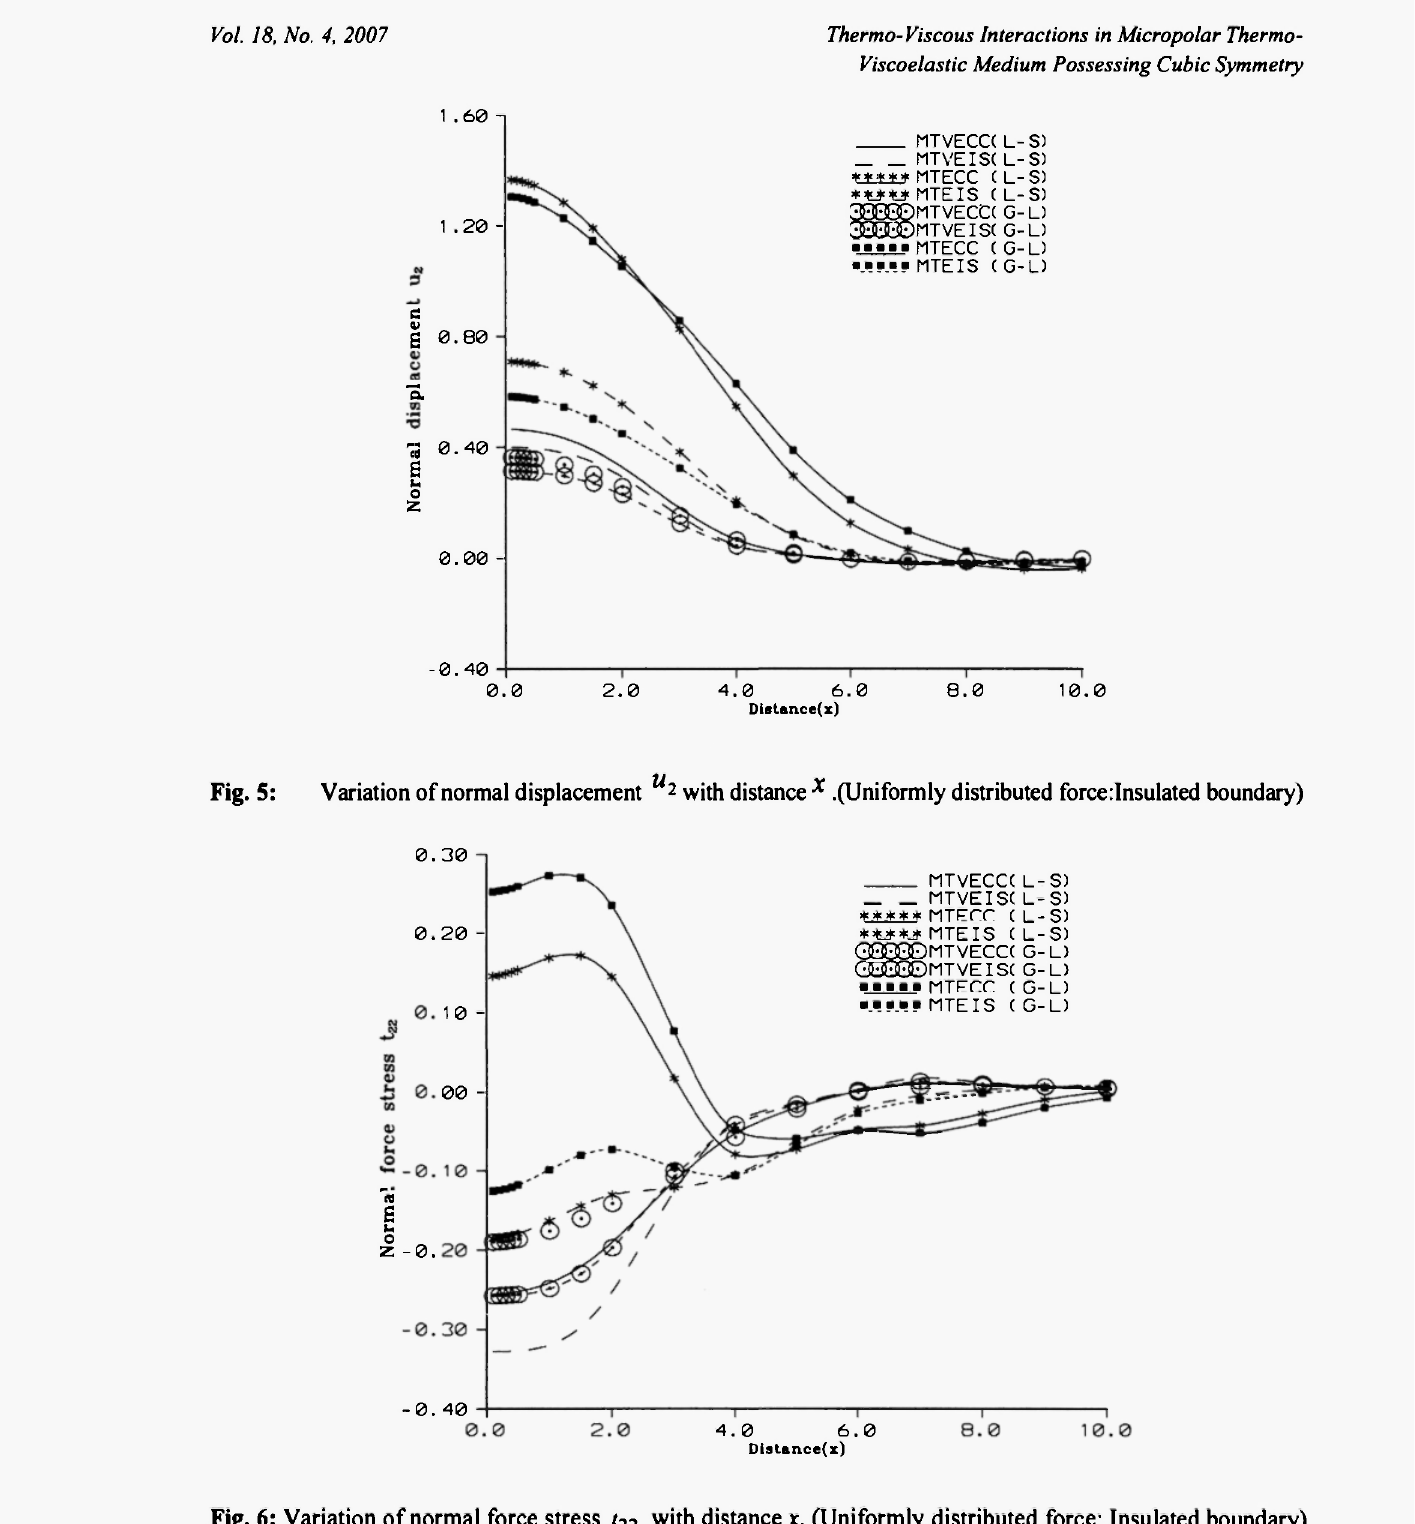
Fig. 6: Variation of normal force stress t 2 2 with distance x. (Uniformly distributed force: Insulated